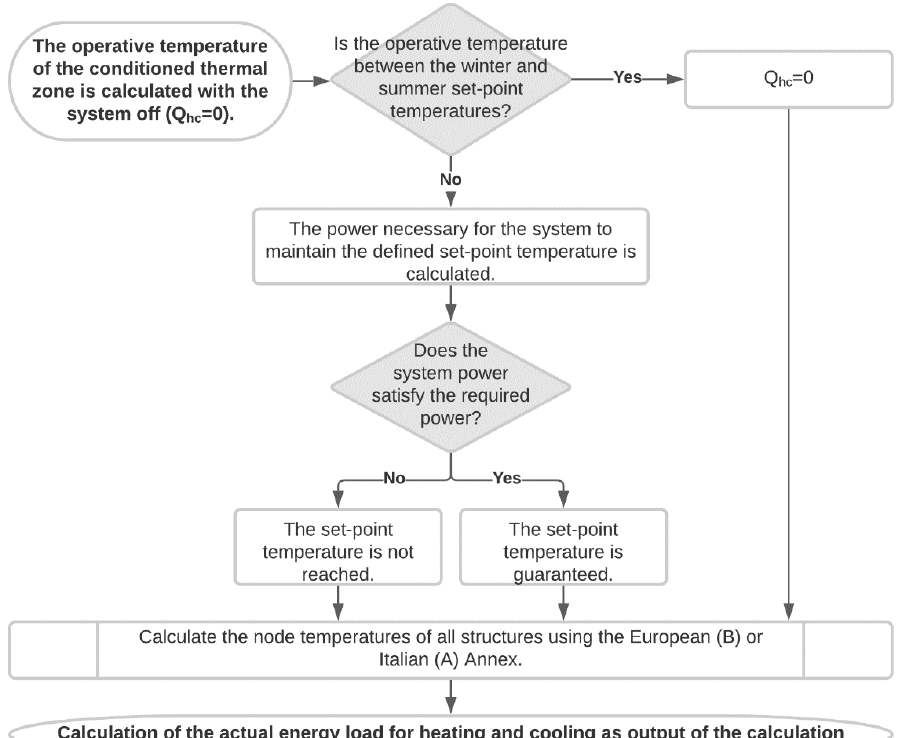
Figure 1. Flow chart of the calculation algorithm.